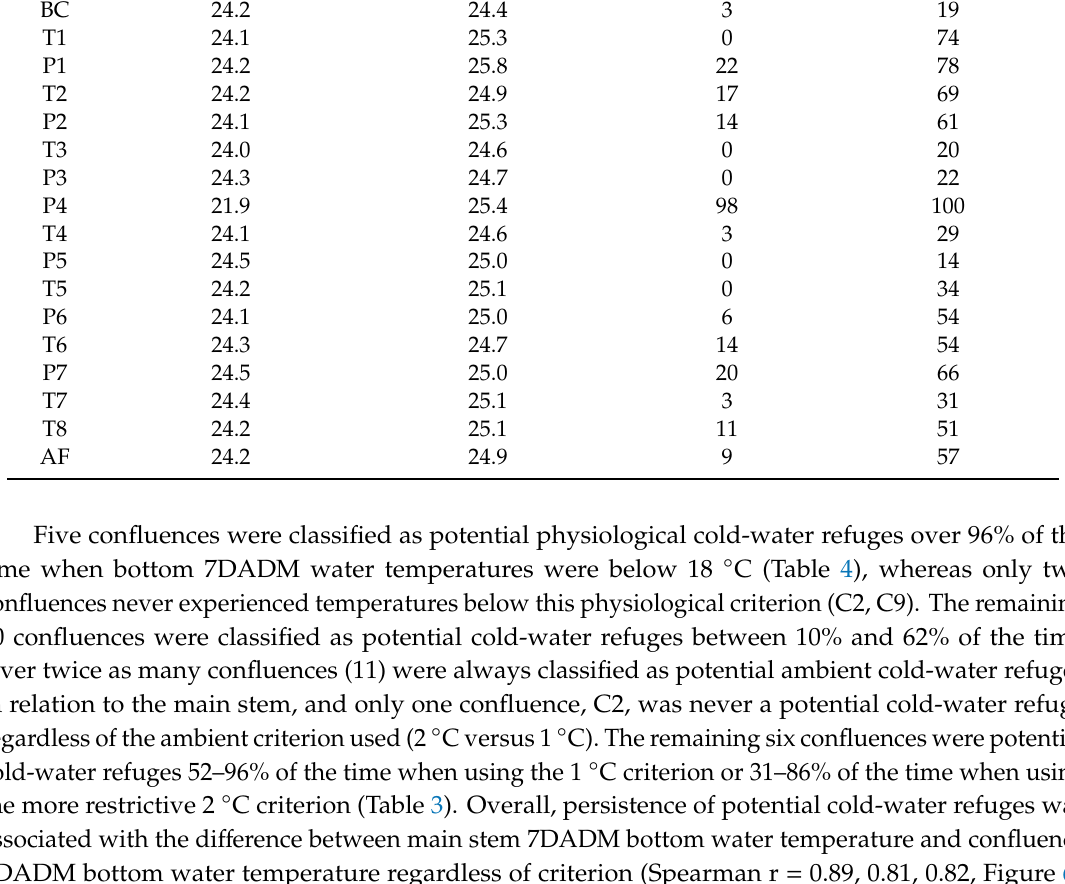
Table 3. Seven-day average daily maximum (7DADM) water temperature at main stem sites where instream loggers were deployed at the surface and on the bottom of the river. Cold-water refuge persistence (percentage of time) is presented for two ambient criteria based on whether the di ff erence between the surface water temperature and bottom water temperature was greater than 1 ◦ C or 2 ◦ C for at least an hour a day. Site Main Stem Water Temperature 7DADM ( ◦ C) Cold-Water Refuge Persistence (%) Bottom Surface 2 ◦ C